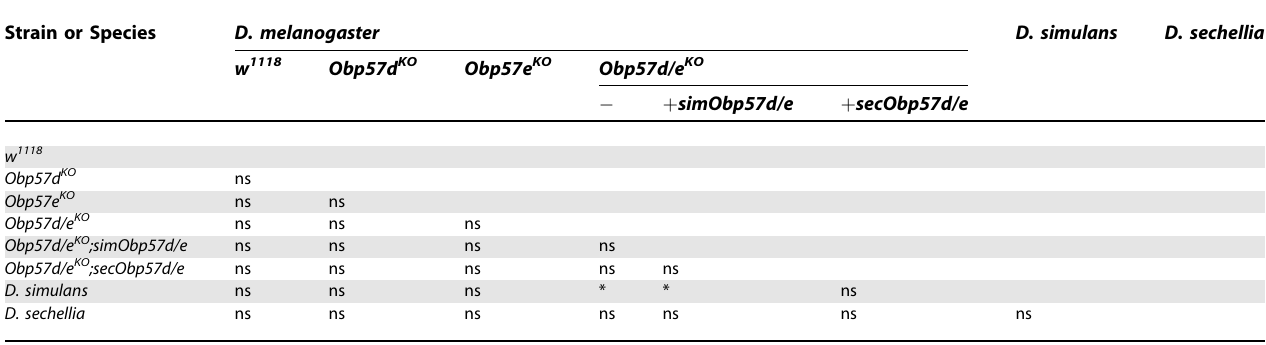
Table 2. Statistical Analysis of Results of Oviposition Site–Preference Assay (Butyric Acid) Strain or